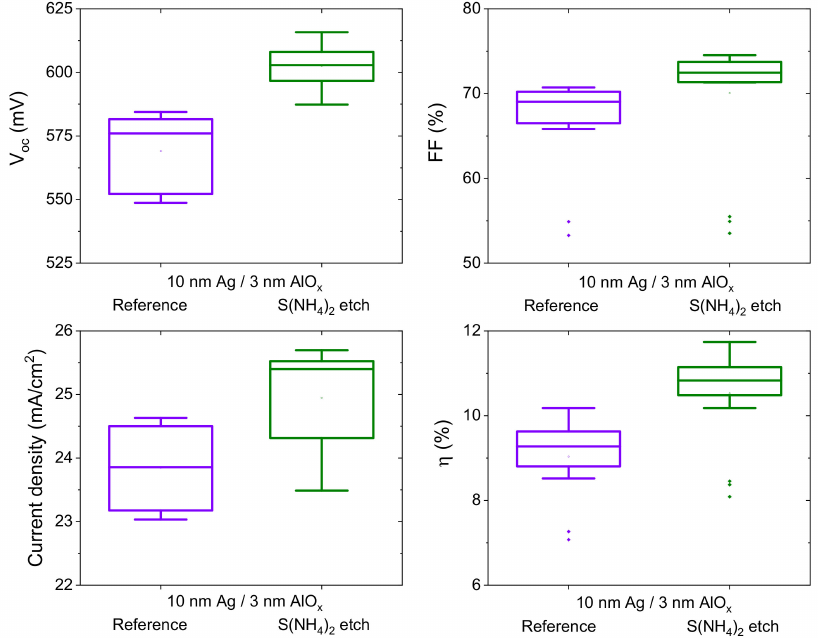
Figure 10. JV parameters of Ag/AlO x back reflector with and without ammonia sulfide